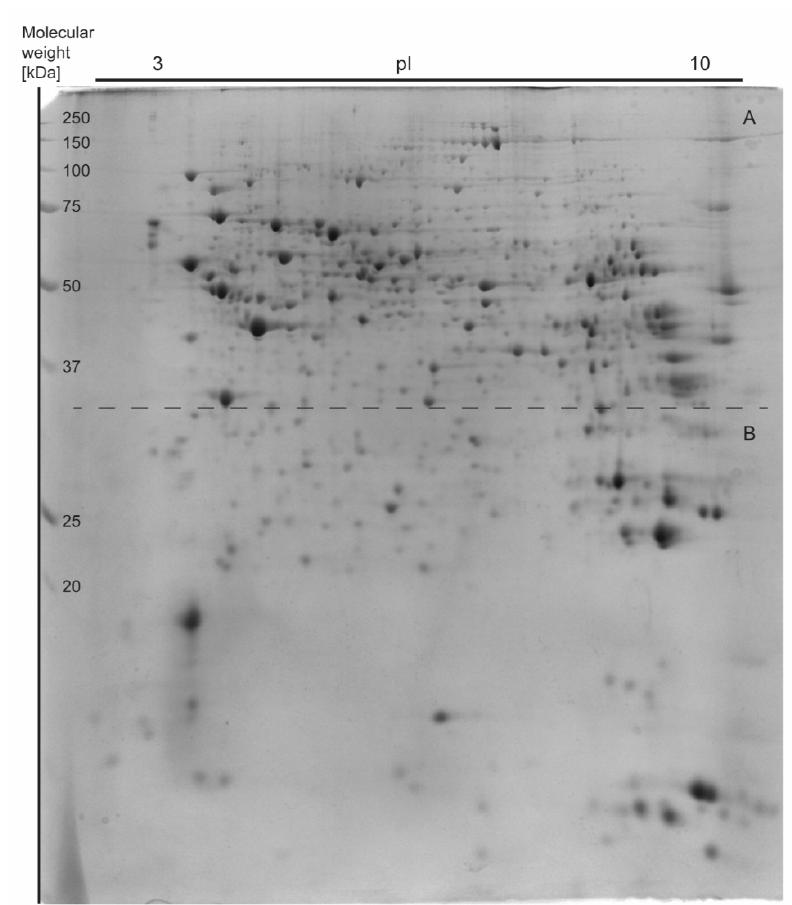
Figure 3. The representative two-dimensional electrophoresis gel image of mouse liver proteins. A total of 600 μ g of whole liver proteins was applied to the IPG strip (non-linear pH 3–10, 17-cm length) for the first dimension and then the second dimension was performed on 12% SDS-PAGE gels. The 2DE gel (18 cm × 20 cm × 1.00 mm) was stained with Coomassie Brilliant Blue G-250. The figure was divided into two parts (A and B) according to the dashed